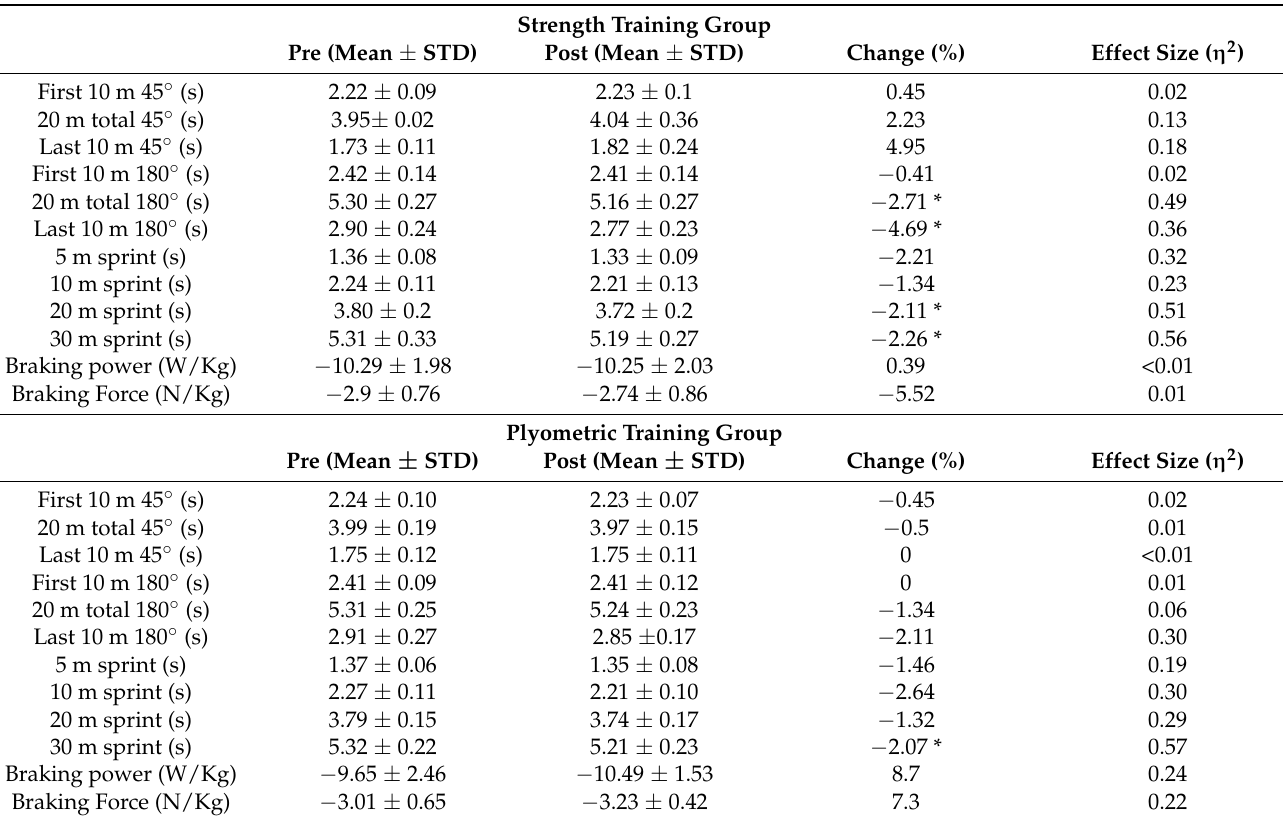
Table 4. Descriptive statistics of performance changes in the change of direction test, 30 m sprint and horizontal braking test for both the strength and plyometric training group.